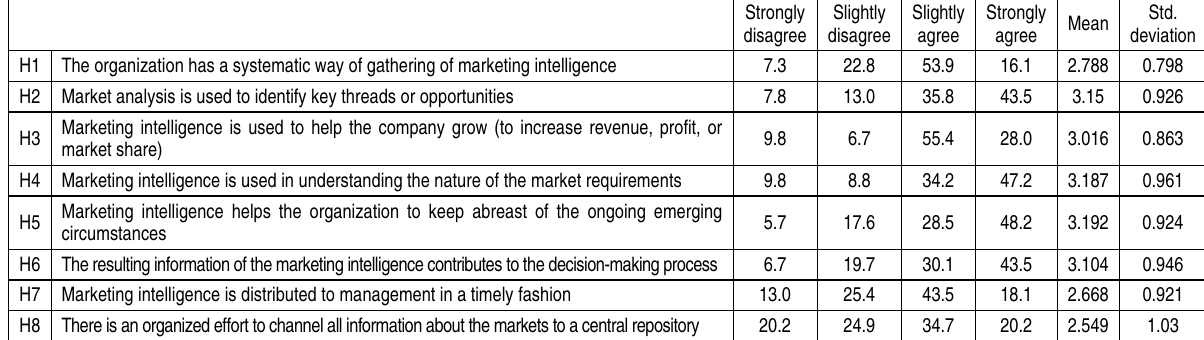
Table 3. Results of the questionnaire on marketing